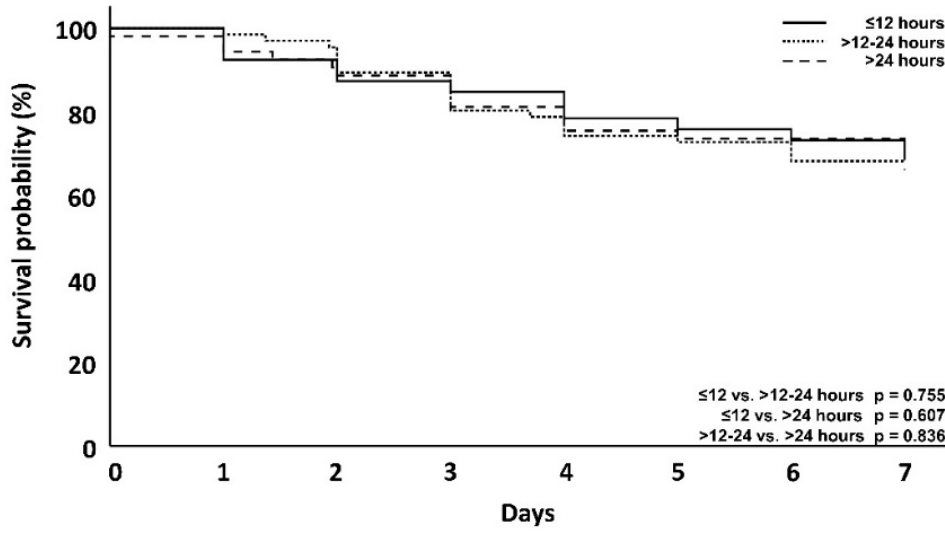
Figure 7. Kaplan–Meyer survival analysis of CytoSorb treated patients at day 7 with regard to different delay groups. The p -value is via Log-rank test. * = Statistically significant using Bonferroni- adjusted alpha critical value = 0.017 (no such cases).